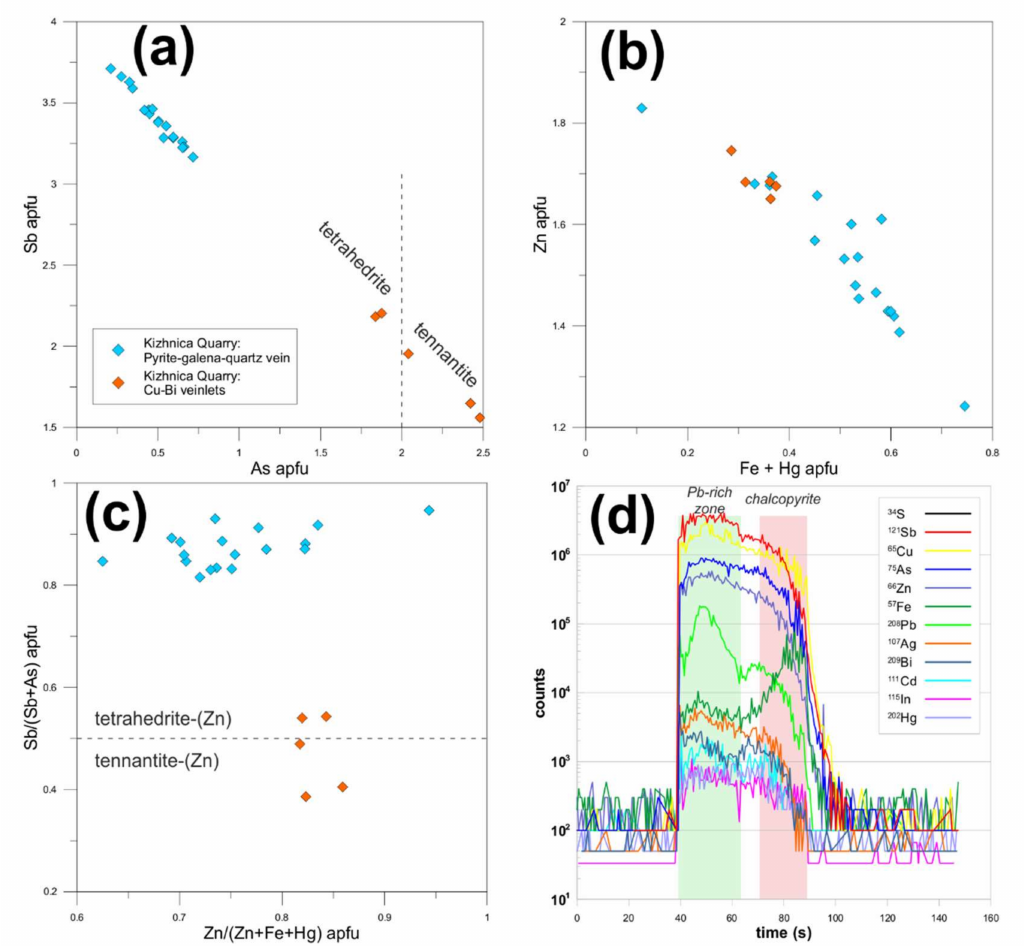
Figure 13. Compositional relationships in the tetrahedrite group minerals (TGM) from the Kizhnica quarry: ( a ) Sb vs As binary plot (apfu); ( b ) Zn vs Fe+Hg binary plot (apfu); ( c ) Sb/(Sb + As) vs Zn/(Zn + Fe + Hg) (apfu); ( d ) spectra of TGM with Pb-rich zone; increase in Fe is associated with the presence of chalcopyrite